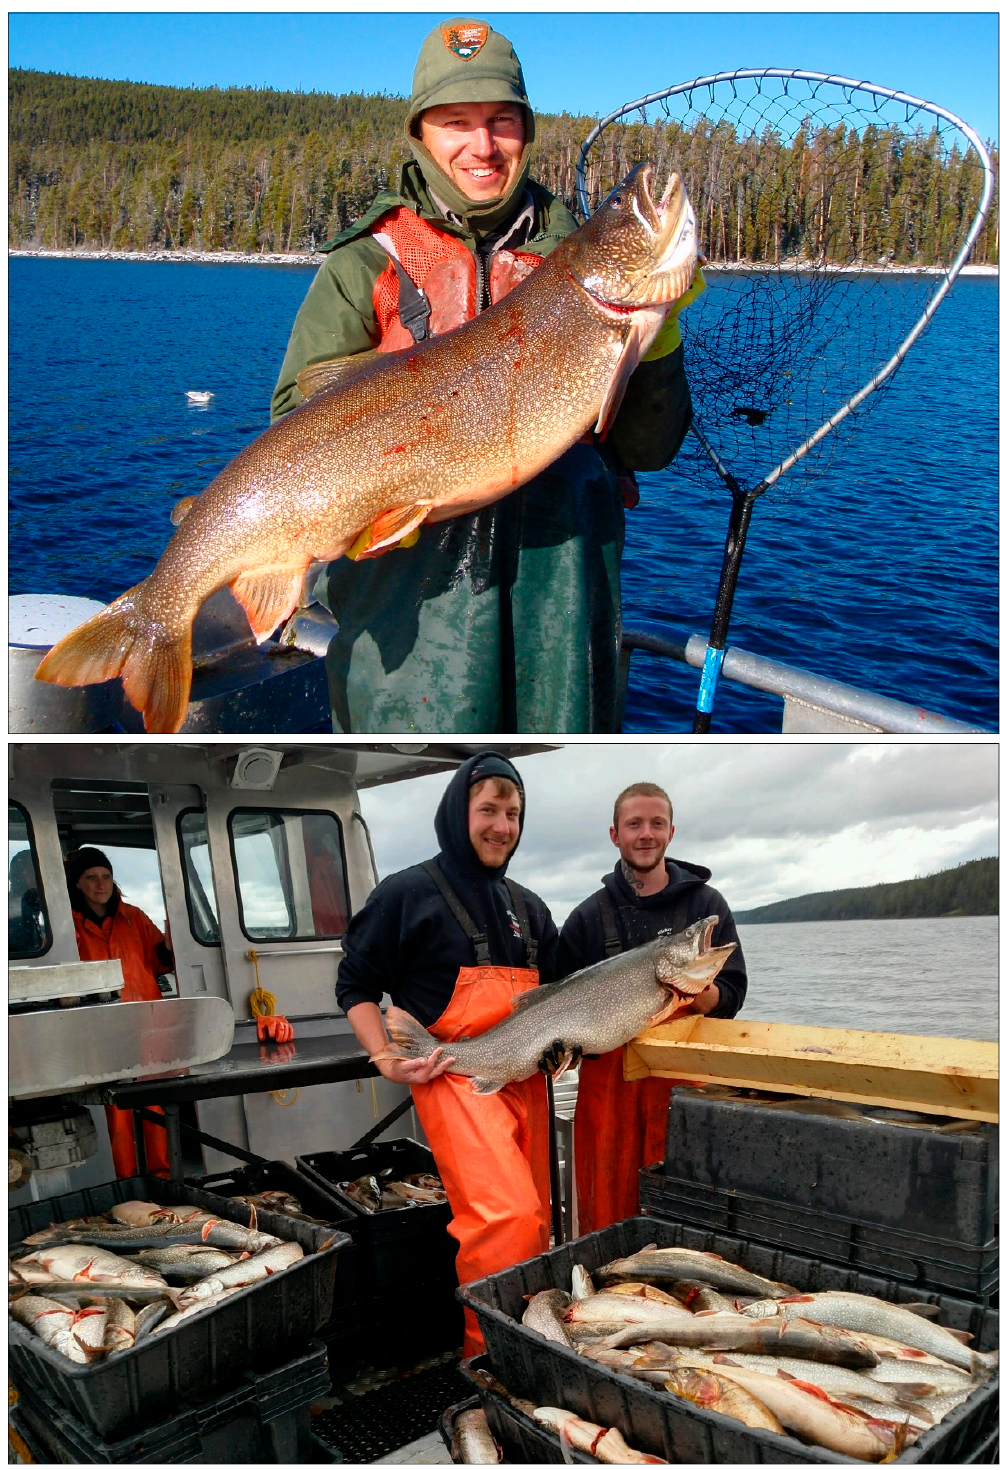
Figure A3. Invasive lake trout are a large-bodied, long-lived, and cold-adapted predatory species that became inadvertently introduced to Yellowstone Lake and were first discovered in 1994. They then became established as a new apex predatory trophic level within the lake. Because they are deep-water dwelling and do not use tributary streams, they are inaccessible to piscivorous avian and terrestrial wildlife and do not serve as an ecological substitute for native cutthroat trout.